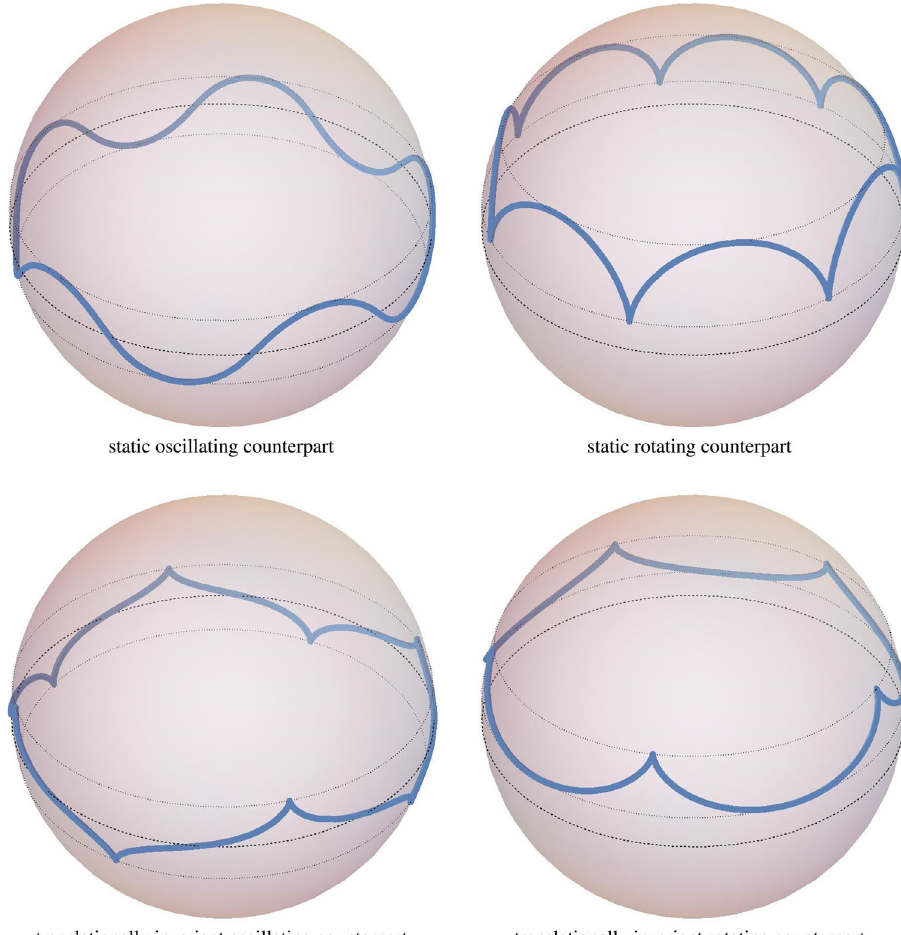
Fig. 3 The four classes of elliptic string